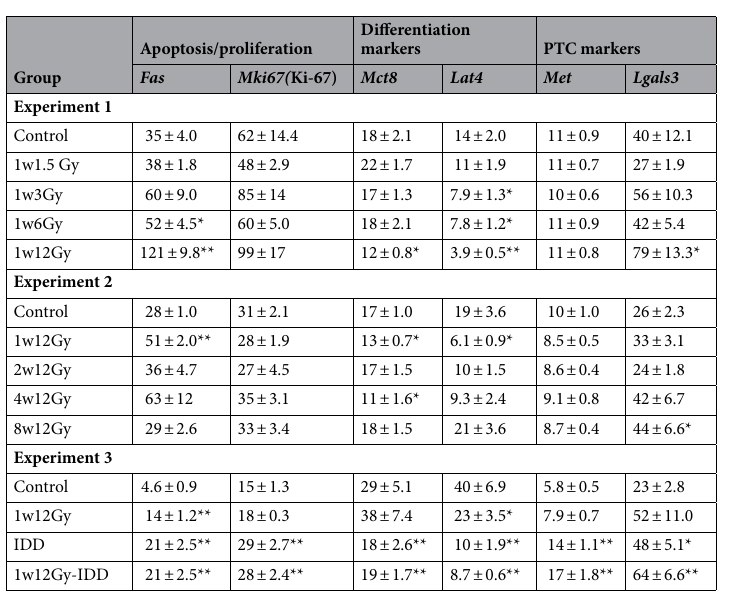
Figure 4. TUNEL and Ki-67 staining in the thyroid hyperplasia and adenoma of the neonatally X-irradiated rats fed with IDD. The numbers of TUNEL ( a ) or Ki-67 ( b ) positive cells in the thyroid of 29-week-old rats in Control, 1w12Gy, IDD, and 1w12Gy-IDD (hyperplasia and adenoma regions). Representative TUNEL ( c–f ) and Ki-67 ( g–j ) staining in Control ( c , g ), 1w12Gy ( d , h ), IDD ( e , i ), and 1w12Gy-IDD, adenoma region ( f , j ). Arrows indicate TUNEL positive staining. *, ** indicate significant difference from Control (* p < 0.05, ** p < 0.01).